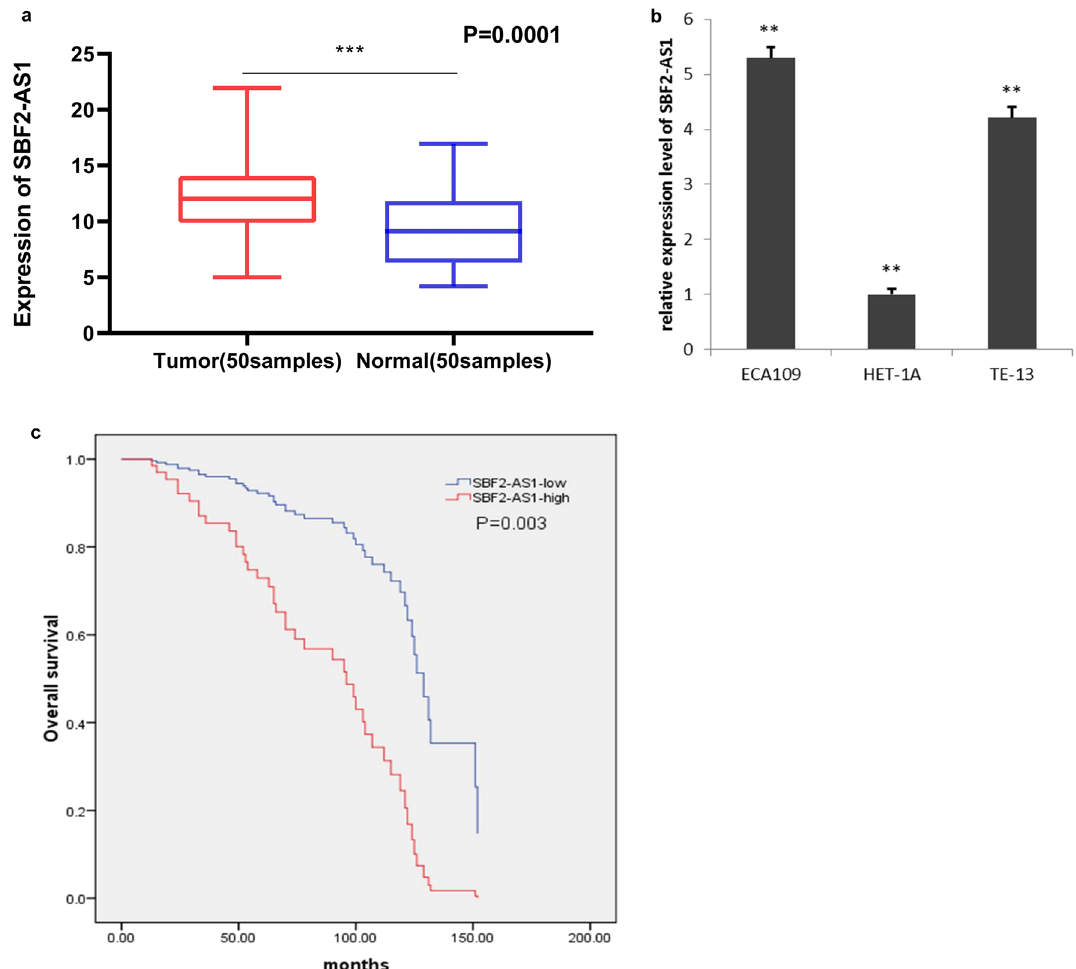
Figure 1. SBF2-AS1 is upregulated in ESCC tumours and cells, while miR-338-3P and miR-362-3P is low in ESCC. ( a ) Relative ratios between SBF2-AS1 expression in 50 ESCC tissues and that in50 normal oesophageal tissues. ( b ) The expression of SBF2-AS1 in oesophageal squamous cell carcinoma cells and normal oesophageal cells was detected by RT-PCR. ( c ) Analysis of overall survival in patients with low or high SBF2-AS1 expression levels. Data are shown as the mean ± SEM. *P < 0.05, **P < 0.01, ***P <